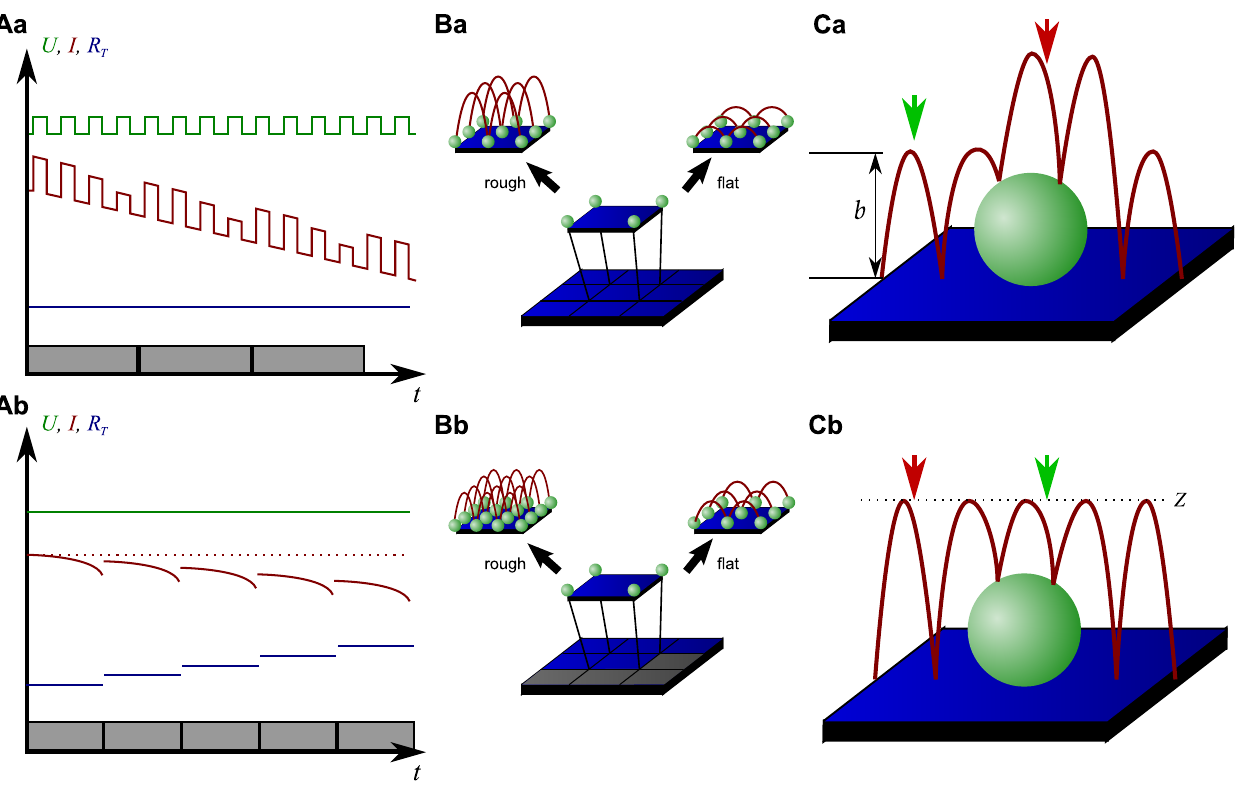
Figure 6. Improvements of backstep mode. ( A ) shows two methods to circumvent the effect of DC drifts, either by applying pulses ( Aa ) or by adapting the reference resistance ( Ab ). ( B ) shows improvements of the temporal resolution by changing the retraction distance ( Ba ) or both the retraction distance and the resolution ( Bb ) after a low resolution pre-scan. ( C ) shows two methods of pipette retraction, either by a pre-defined distance ( Ca ) or to a pre-defined position ( Cb ). Red arrows indicate regions that require long approaches of the probe, green arrows mark regions that require only short